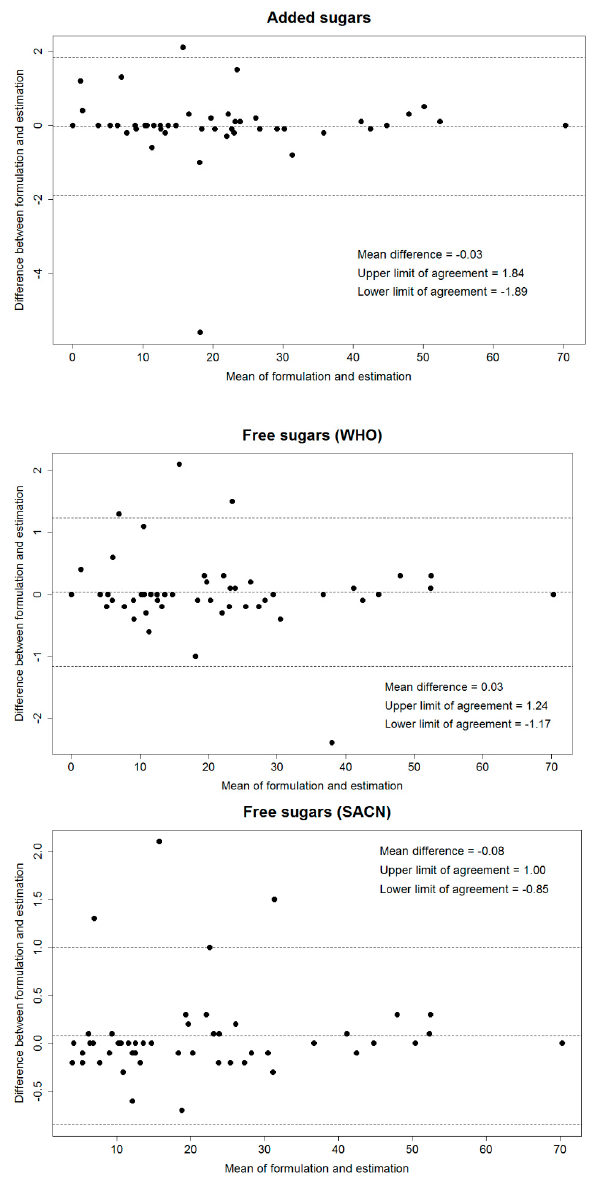
Figure 3. Bland and Altman plot for difference in added sugars and free sugars values (g/100 g) between known formulations and estimation of a data analyst for 50 food items. Added sugars: sugar - table + sugar - other; Free sugars (WHO): Added sugars + sugar-honey + sugar - fruit juice; Free sugars ( SACN): Free sugars (WHO) + sugar - pureed fruit. WHO: World Health Organization. SACN: Scientific Advisory Committee on Nutrition.